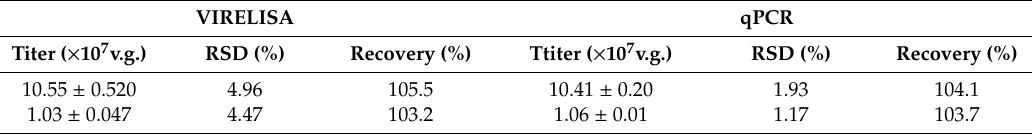
Table 5. VIRELISA for AAV1 in crude lysate and comparison with